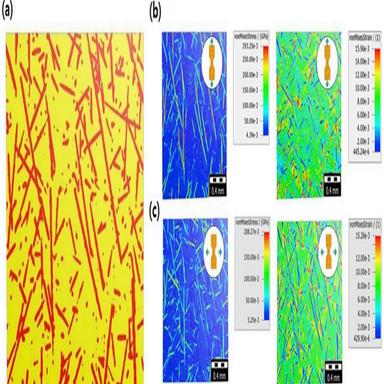
Color map images of the Von Mises stress/strain for the (a) extended regions of the longitudinal specimen. Simulation images of the longitudinal specimen when the uniaxial load was applied (b) in the Z direction parallel to the fiber orientation and (c) in the X direction perpendicular to the fiber orientation. (For interpretation of the references to color in this figure legend, the reader is referred to the Web version of this article.)